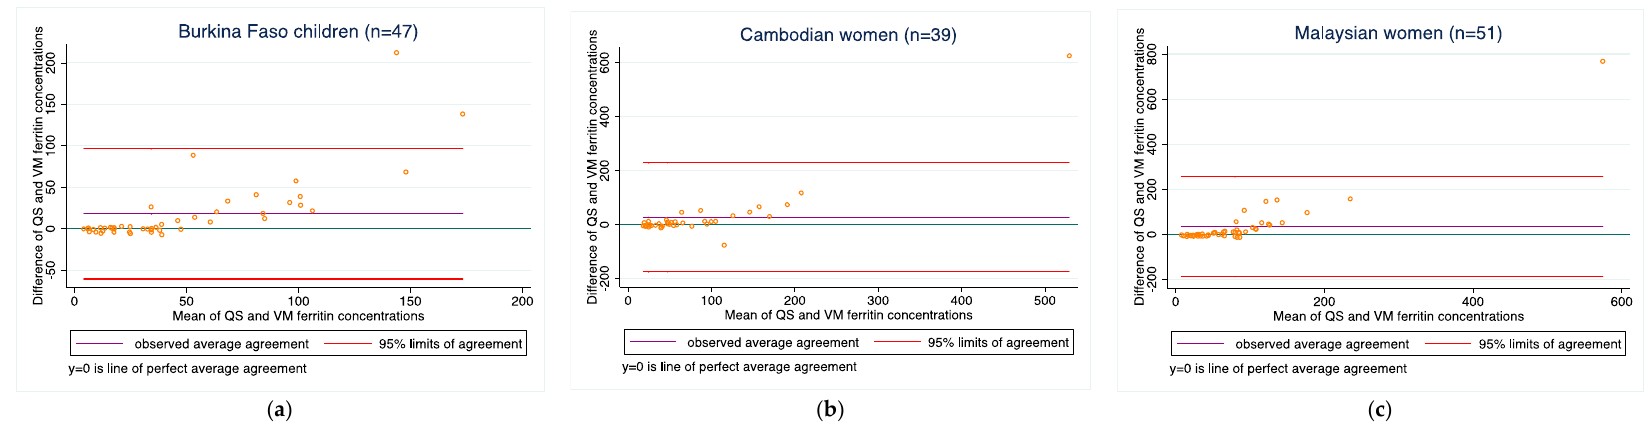
Figure 1. Ferritin concentrations for ( a ) Burkina Faso children ( n = 47); ( b ) Cambodian women ( n = 39); and ( c ) Malaysian women ( n = 51). QS: ferritin results obtained on the Quansys ELISA; VM: ferritin results obtained from the VitMin lab.